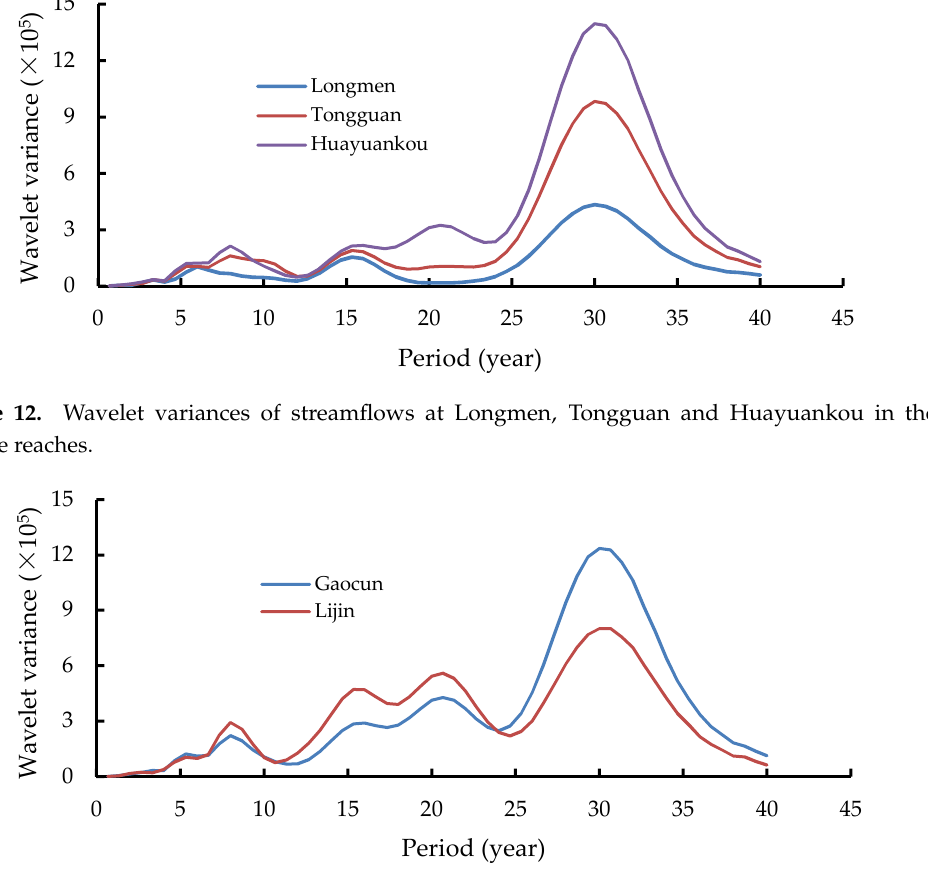
Figure 11. Wavelet variances of streamflows at Tangnaihai, Lanzhou, Xiaheyan, Shizuishan and Toudauguai in the upstream reaches.